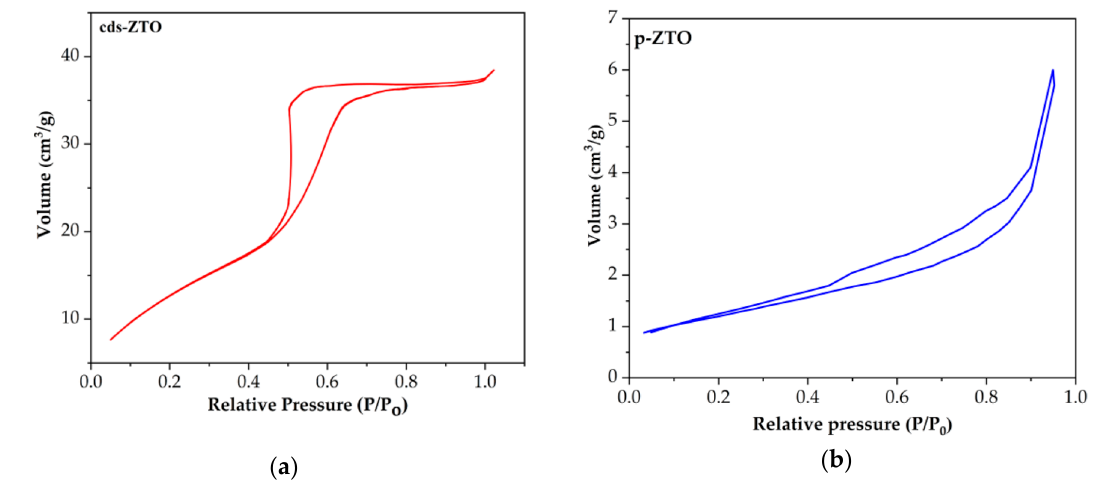
Figure 6. N 2 adsorption–desorption isotherms of ZTO synthesized ( a ) cds-ZTO and ( b ) p-ZTO.